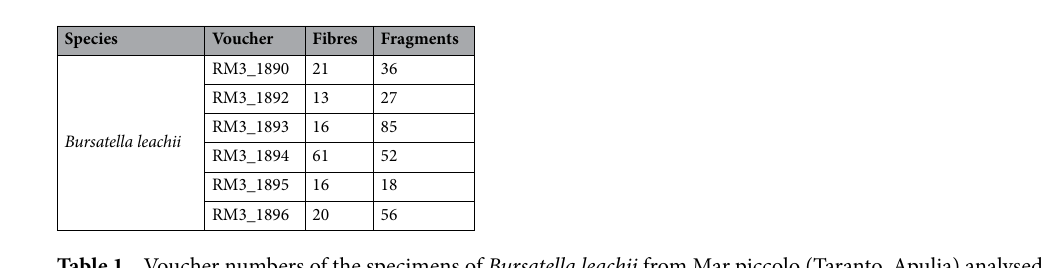
Table 1. Voucher numbers of the specimens of Bursatella leachii from Mar piccolo (Taranto, Apulia) analysed with the relative number of fibres and fragments of microplastics detected.